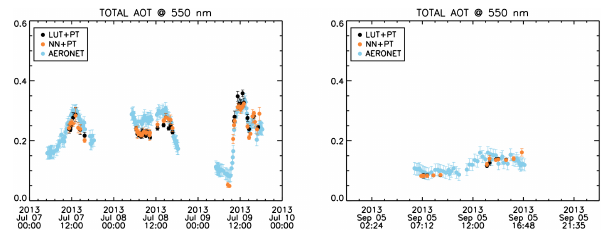
Figure 5. Time series of the total AOT retrieved by the LUT + PT scheme (black circles), the NN + PT scheme (orange circles), and the AERONET direct sun level 1.5 product (sky-blue circles): be- tween 7 and 9 July 2013 (left) and on 5 September 2013 (right).